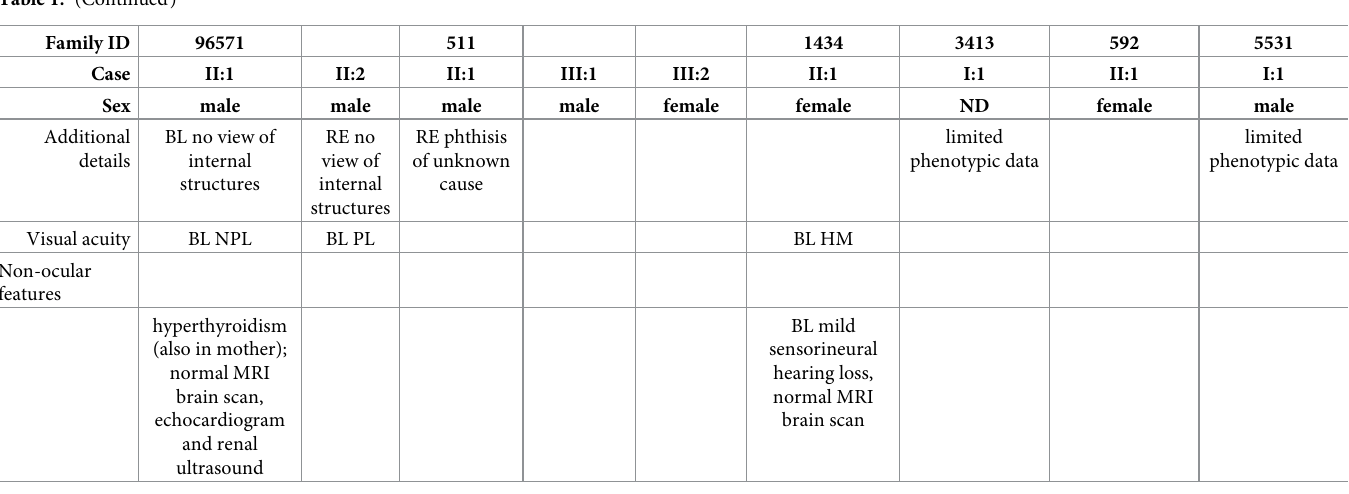
To identify MAB21L1 interactors that are specific either to wild-type or mutant protein we performed immunoprecipitation followed by mass spectrometry (IP-MS) on biological tripli- cates derived from independent clones of the inducible cell lines expressing GFP alone, wild- type MAB21L1, Arg51Leu MAB21L1 and Arg51Gln MAB21L1. More than 1000 proteins were identified using IP-MS but most were non-specific or inconsistently associated with the geno- types ( Fig 3A ). The levels of MAB21L1 were similar in wild-type and mutant pull-down sam- ples suggesting uniform pulldown ( Fig 3B ). 72 proteins showed consistent association with all forms of MAB21L1 with no association with GFP alone. Pathway analysis of these proteins revealed a significant over-representation of RNA-binding proteins and TALE-like homeodo- main containing proteins ( Table 2 ). Indeed, four of the five most abundant proteins were tran- scription factors of this latter class (MEIS1, MEIS2, PBX1 and PBX3) ( Fig 3D ). A